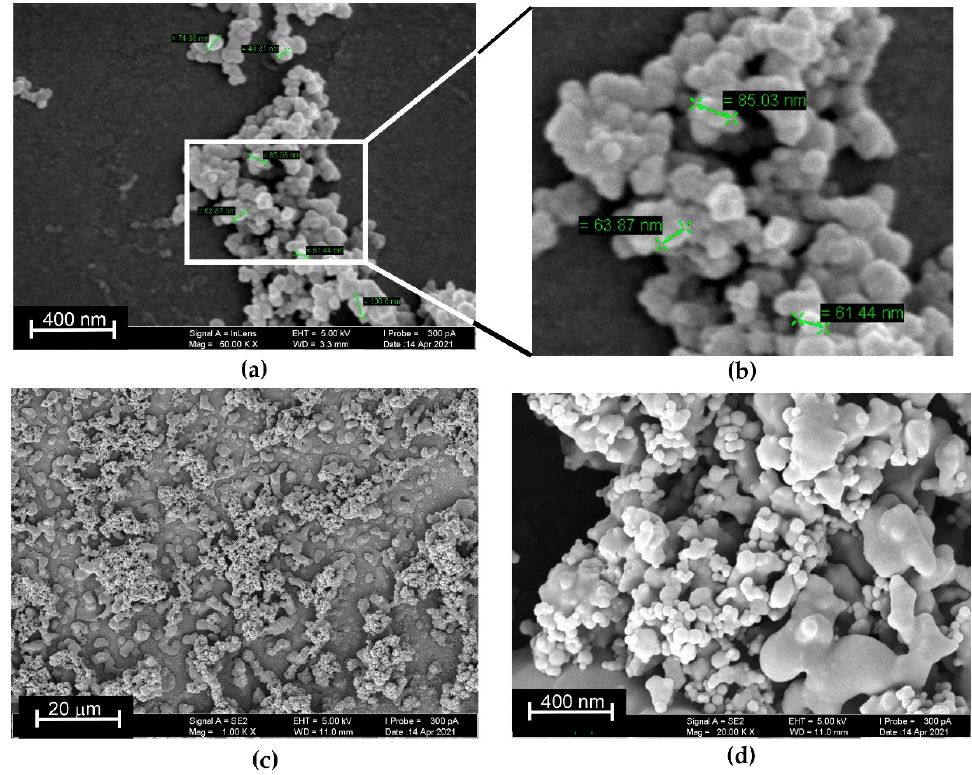
Figure 7. SEM images of the electrode surface covered with CB/AY and treated with DMF ( a , b ) and that preliminary treated with DNA solution and then additionally treated with DMF ( c , d ).